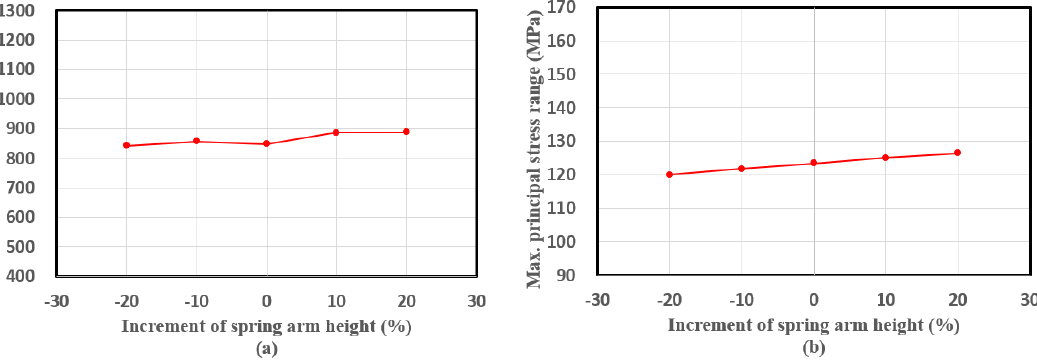
Figure 10. Stress variation with the spring arm height: ( a ) maximum principal stress; ( b ) maximum principal stress range.